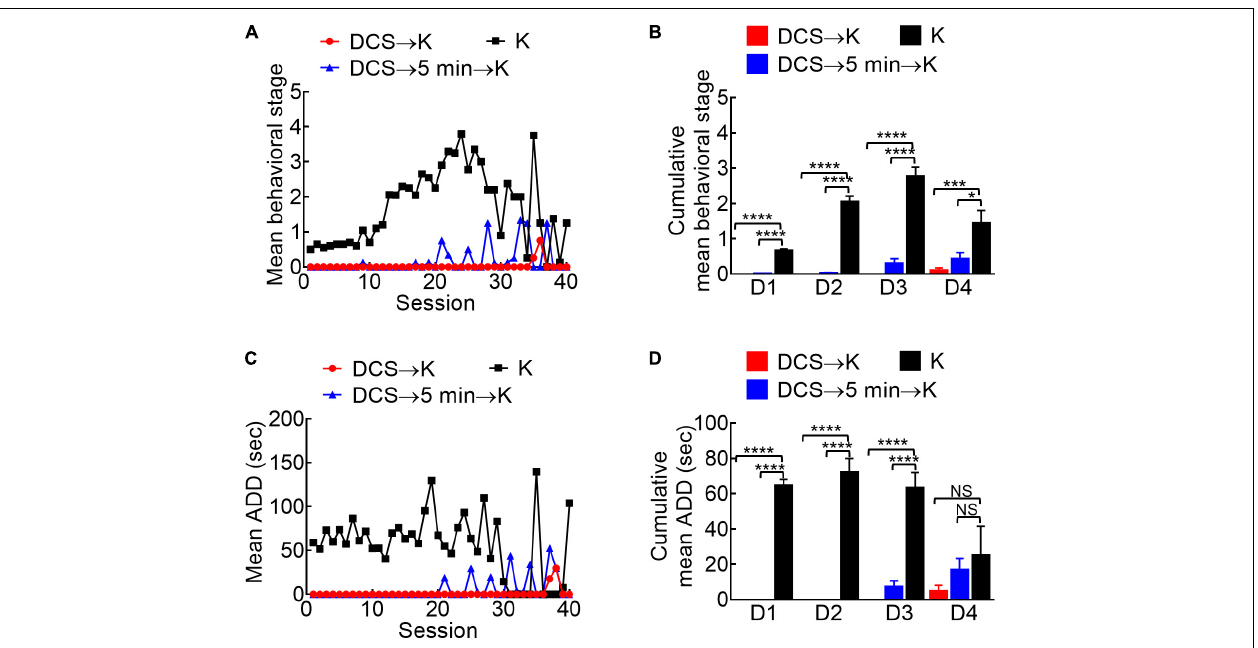
FIGURE 5 | Marked anti-epileptogenic effect of DCS if given either immediately before or 5 min before the kindling stimuli. (A) Mean behavioral stage at each of the 40 stimulation sessions with 100 µ A, 10-s DCS given immediately before or 5 min before the kindling stimuli (DCS → K, red symbols, n = 4; DCS → 5 min → K, blue symbols, n = 4) is, in general, lower than that with kindling only (K, black symbols, n = 10). Only the mean values are shown [SEM is omitted for the sake of clarity]. (B) Cumulative mean behavior stage in each of the 4 days is lower in both DCS groups if compared to the challenge only group ( n = 10, 10, 10 each day from the mean of 4, 4, 10 rats for DCS → K, DCS → 5 min → K, and K group, respectively). (C) The mean ADD from bilateral BLAs after each kindling stimulation is shortened by DCS given either immediately before or 5 min before kindling (DCS → K, red symbols, n = 3; DCS → 5 min → K, blue symbols, n = 3; K, black symbols, n = 4). (D) The cumulative mean ADD in each of the 4 days is lower in both DCS groups than in the kindling only group ( n = 10, 10, 10 each day from the mean of 3, 3, 4 rats for DCS → K, DCS → 5min → K, and K group, respectively). * p < 0.05; ** p < 0.01; *** p < 0.001; **** p < 0.0001, Mann–Whitney U